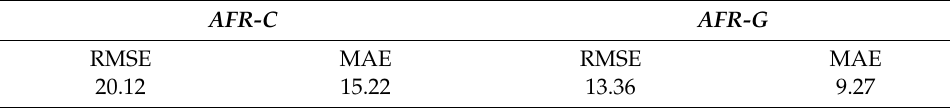
Table 3. Prediction performance of AFR-C and AFR-G .